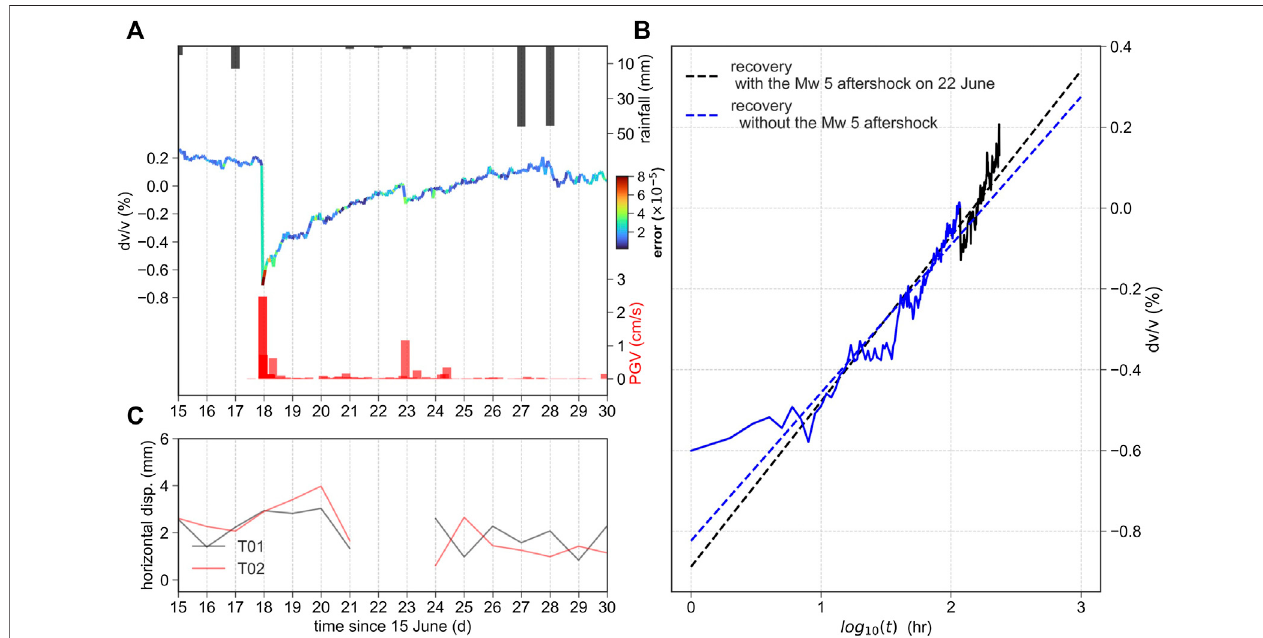
FIGURE 4 | (A) δ v / v decrease and subsequent recovery due to the Changning Mw 5.7 earthquake. (B) δ v / v as a logarithmic function of recovery time for the earthquake (the black dash line characterizes the recovery time with the Mw 5 aftershock on June 22, and the blue dash line characterizes the recovery time without the Mw 5 aftershock). (C) Time series of GNSS horizontal displacements at two stations with a 1-day sampling